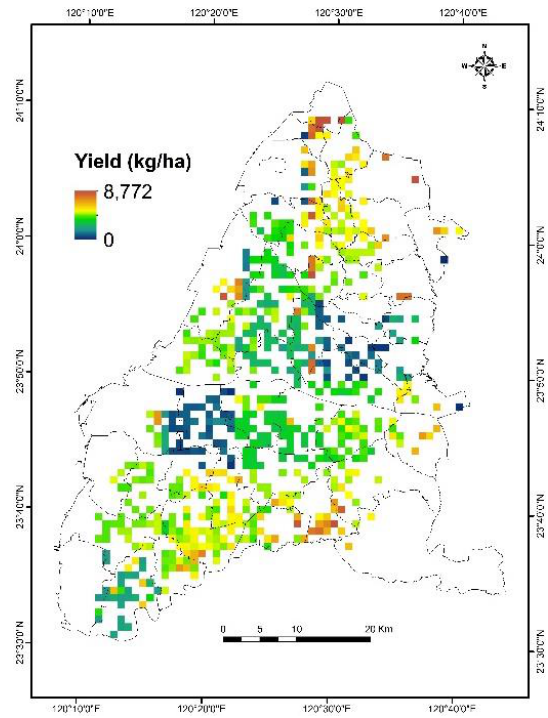
Figure 3. Spatial distributions of simulated rice yield for the first crop in